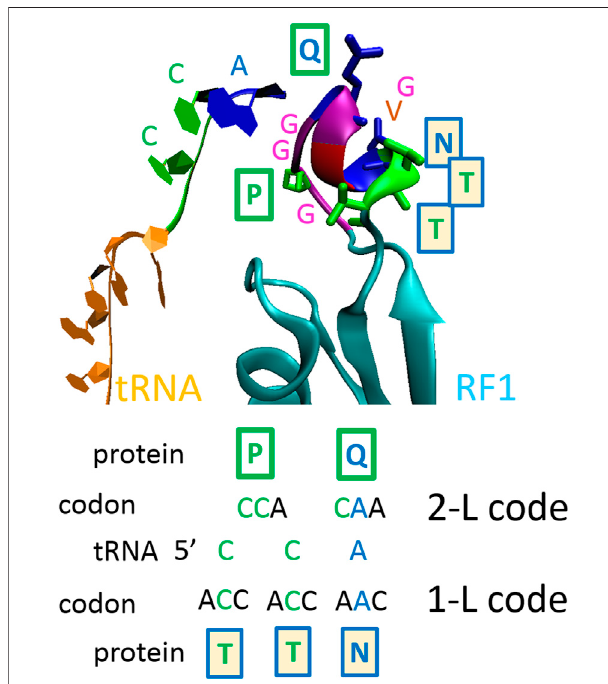
FIGURE 1 | The principle of the proposed protein – RNA recognition code. One-letter code — second nucleotide in codons; two-letter code — fi rst two nucleotides in codons (Nahalka, 2014, 2019). The ribosomal release factor 1 (RF1) interacting with P-site tRNA (3D5A). At a shorter distance, proline 227 (P) and glutamine 230 (Q) recognize 5 ’ CCA nucleotide sequences usingthe2-Lcode;atalongerdistance,asparagine233(N),threonine234(T) andT235recognize3 ’ ACCnucleotidesequencesusing1-Lcode.IntheRF1s of all organisms, the GGQ motif is inserted into the peptidyl transferase center and is positioned to contribute directly to peptidyl-tRNA hydrolysis (Laurberg et al., 2008). The GGQ motif was con fi rmed recently for the recognition of ribose(NahalkaandHrabarova,2021),whichisthesugarcomponentofRNA.